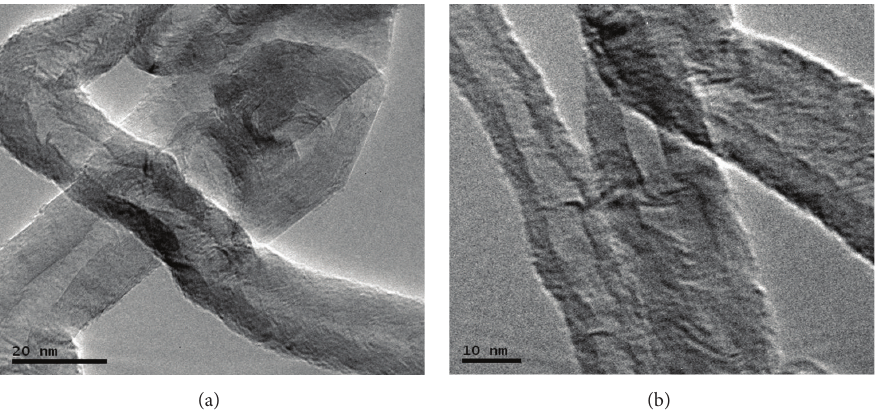
Figure 5: TEM images of CNTs at (a) low resolution and (b) high resolution.